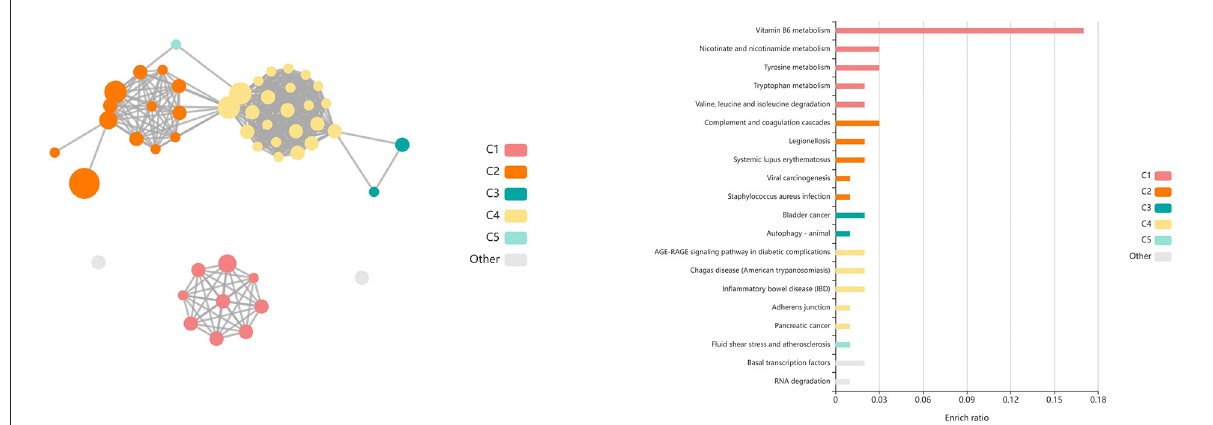
FIGURE6 Clustering of enriched KEGG pathways by term identity from KOBAS-i analysis of DEGs identified between vaccinated and non-vaccinated calves at T2. Each node represents an enriched term, with color corresponding to the unique cluster based on term identity. Each edge (line between nodes) represents a significant correlation between pathway terms. Bar graphs represent the pathway terms found within each pathway (by color) and the level of enrichment (Enrich ratio). KEGG pathways identified between vaccine groups at T2 clustered into five unique clusters. Gray nodes and bar graphed terms represent enriched pathways which did not associate within the clustering